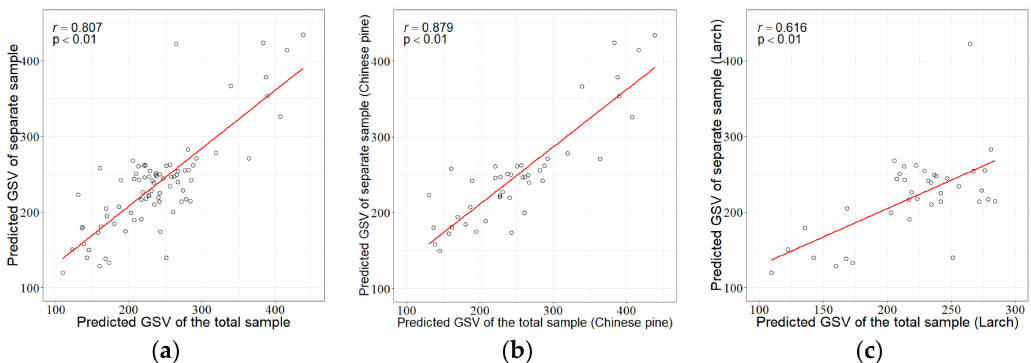
Figure 12. Scatter plots of the GSV predictions by the total or pooled sample plot set against the GSV predictions by separate sample plot sets of tree species: ( a ) all the tree species, ( b ) Chinese pine, and ( c )